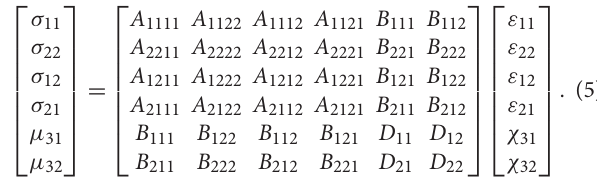
Frontiers in Materials |